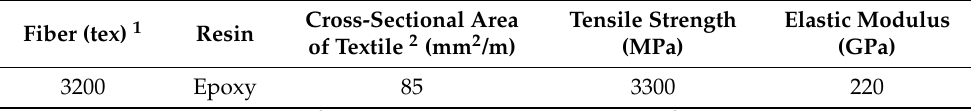
Table 3. Material properties of carbon textile grid (suggested by the manufacturer).